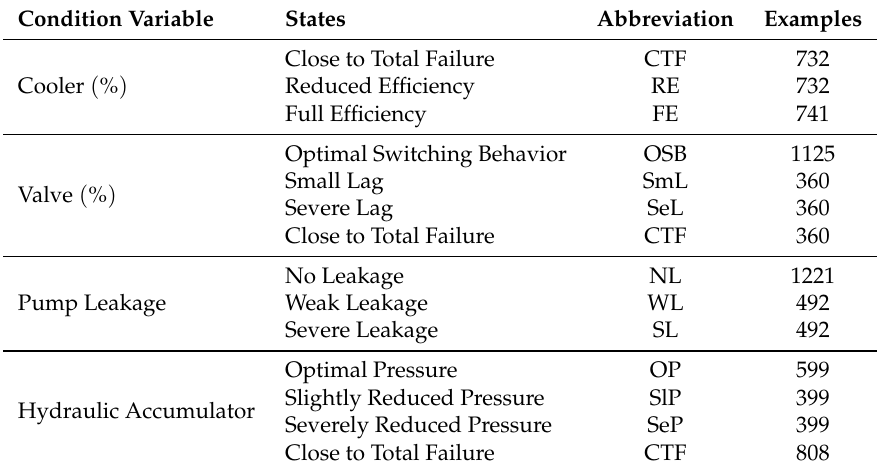
Table 2. Summary of the dataset of the hydraulic test bench. A load cycle with a 60 s duration is repeated 2205 times with the distribution of instances as indicated by the